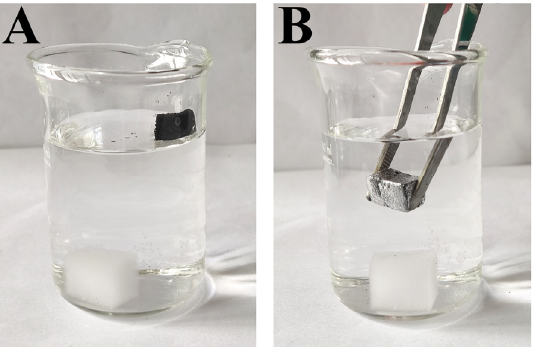
Figure 6. Floating tests of the untreated MS and m-AS/Kaolin@MS on the water surface. Natural appearance after 5 min ( A ). Forcing the m-AS/Kaolin@MS sample to immerse into the water by using a tweezer ( B ).